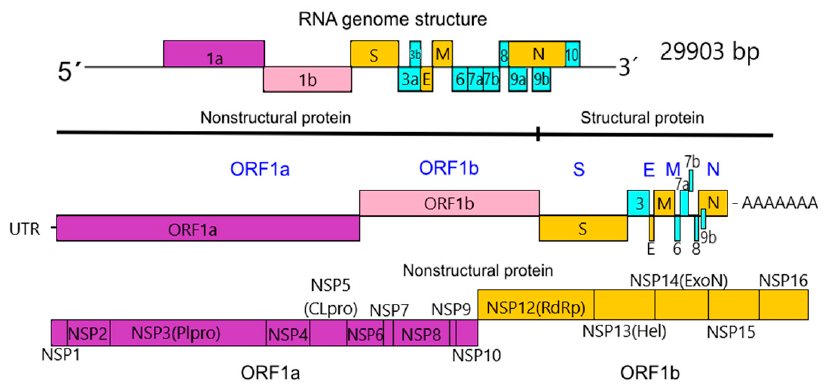
Figure 2. Schematic RNA genome structure SARS-CoV-2. The replicase locus of SARS-CoV-2 contains two substantial open reading frames (ORFs) and four structural proteins. The ORF1a and ORF1b locus encodes 16 nonstructural proteins. Structural proteins, the spike (S) protein is the largest structural protein encoded by the RNA genome. The envelope (E) protein is a small membrane protein that is anchored on the viral envelope and plays a role in the virion assembly and has additional effects on the infected cells of the host. The membrane (M) protein is a multi-membrane spanning protein and the most abundant in the viral envelope. It provides structural support for the virion and plays a role in the assembly and construction of virion particles. Nucleocapside (N) protein complexes with the genome RNA to form the virial nucleocapsid within the viral membrane and interact with the M in the assembly. The N protein may play a role in replicating RNA.